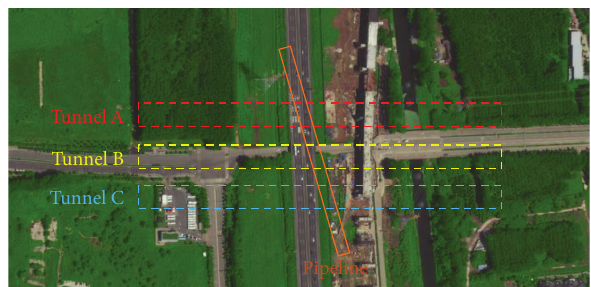
Figure 1: Floor plan between underground excavation and pipeline.